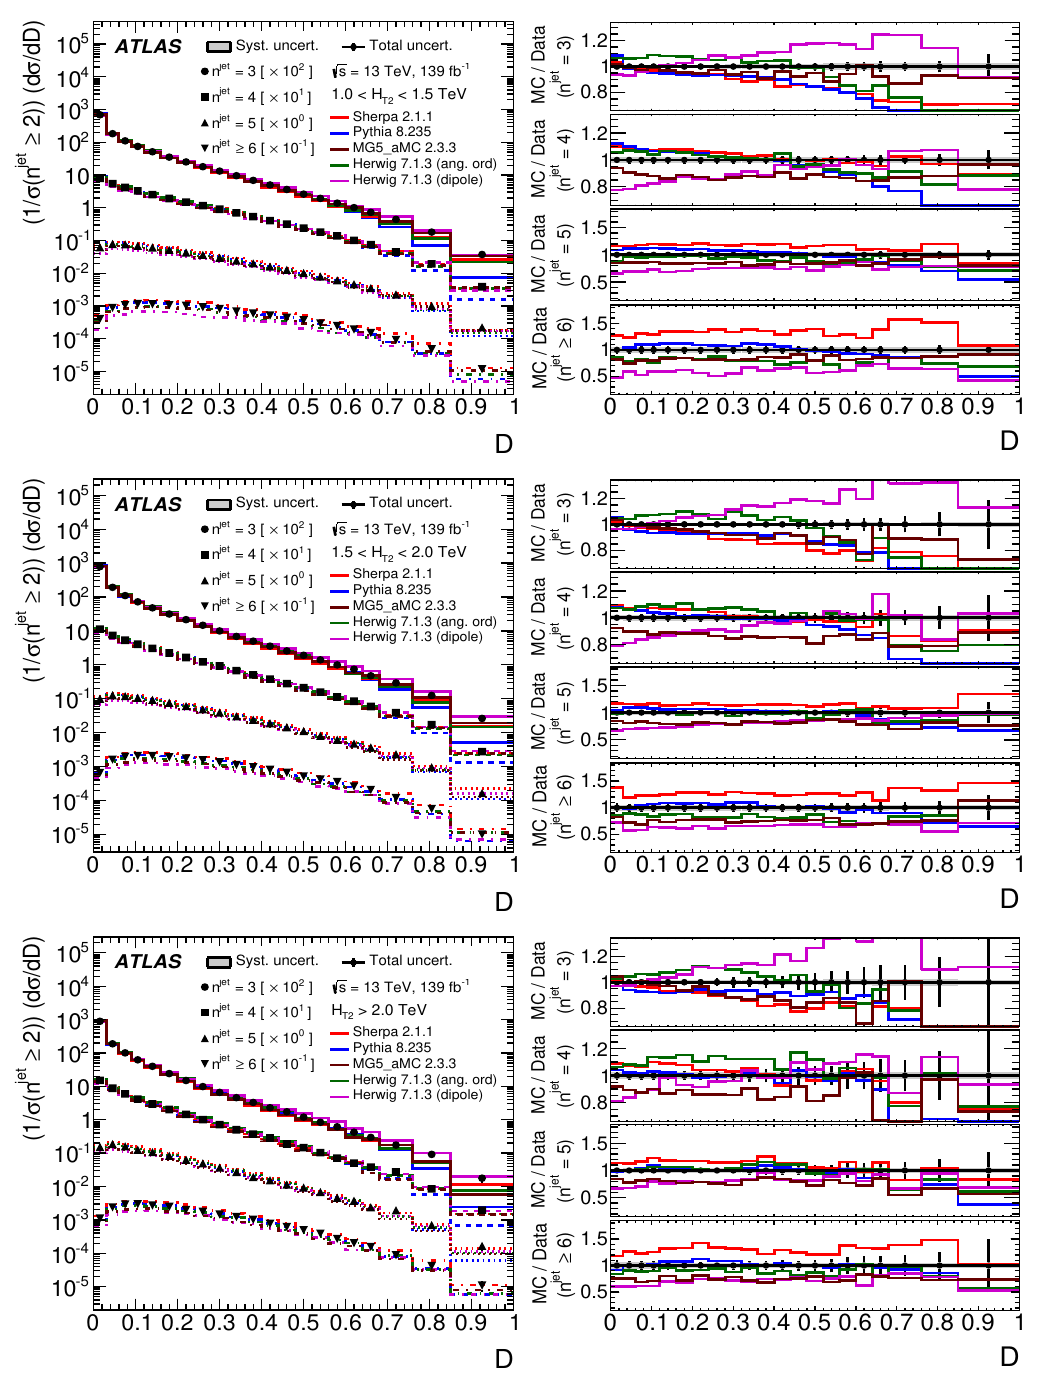
Figure 10 . Comparison between data and MC predictions as a function of D (see eq. 3.6) for different jet multiplicities and energy scales. For illustration purposes, the corresponding differential cross section for each jet multiplicity is multiplied by 10 2 ( n jet = 3), 10 1 ( n jet = 4), 10 0 ( n jet = 5), 10 − 1 ( n jet ≥ 6). The right panels show the ratios between the MC and the data distributions. The error bars show the total uncertainty (statistical and systematic added in quadrature) and the grey bands in the right panels show the systematic